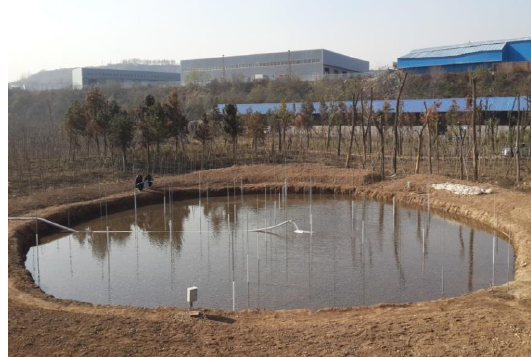
Figure 2. Panorama of the test site.